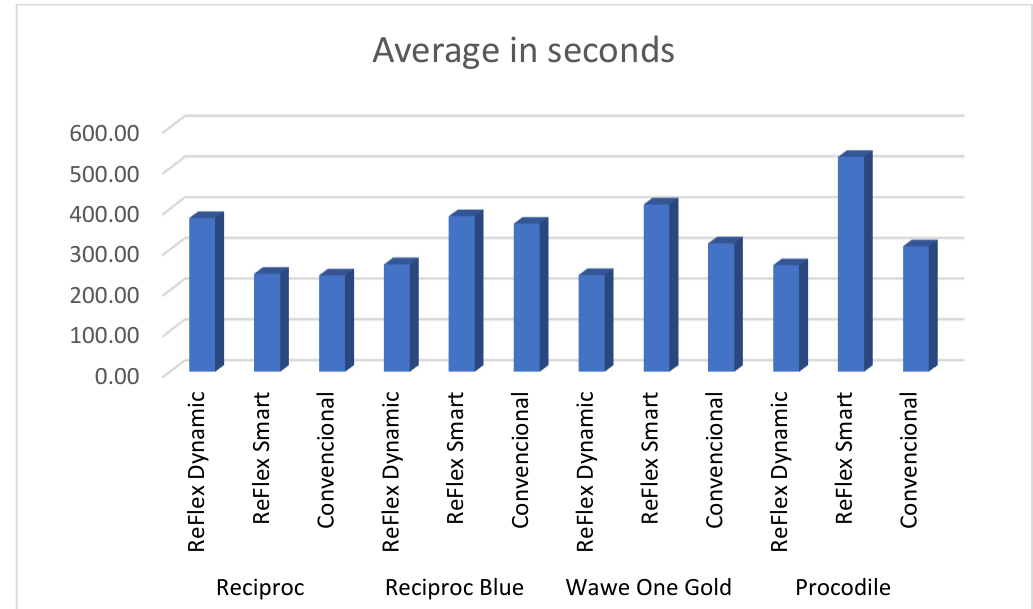
Figure 4. Average in seconds of different systems and movements. In the statistical analysis, significant differences were observed between types of files, between movements, and between the interactions between the type of file and movement. The results of this interaction are presented in Tables 1 and 2. Reciproc shows statistically significant differences between Reflex Dynamic and Reflex Smart and between Reflex Dynamic and conventional. Reciproc Blue shows statistically significant differences between ReFlex Smart and ReFlex Dynamic. Wave One Gold shows statistically significant differences between ReFlex Smart and Reflex Dynamic, and Procodile